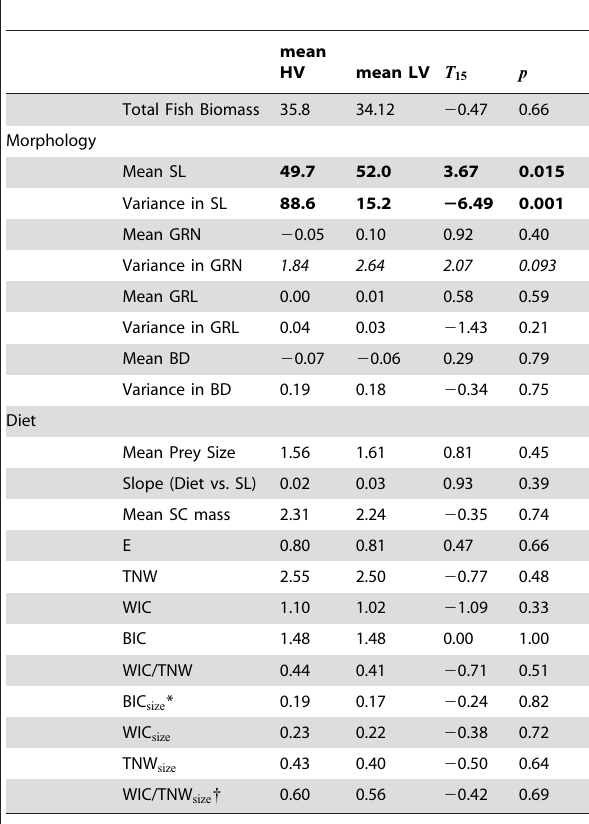
Table 2. Treatment effects on population-level stickleback